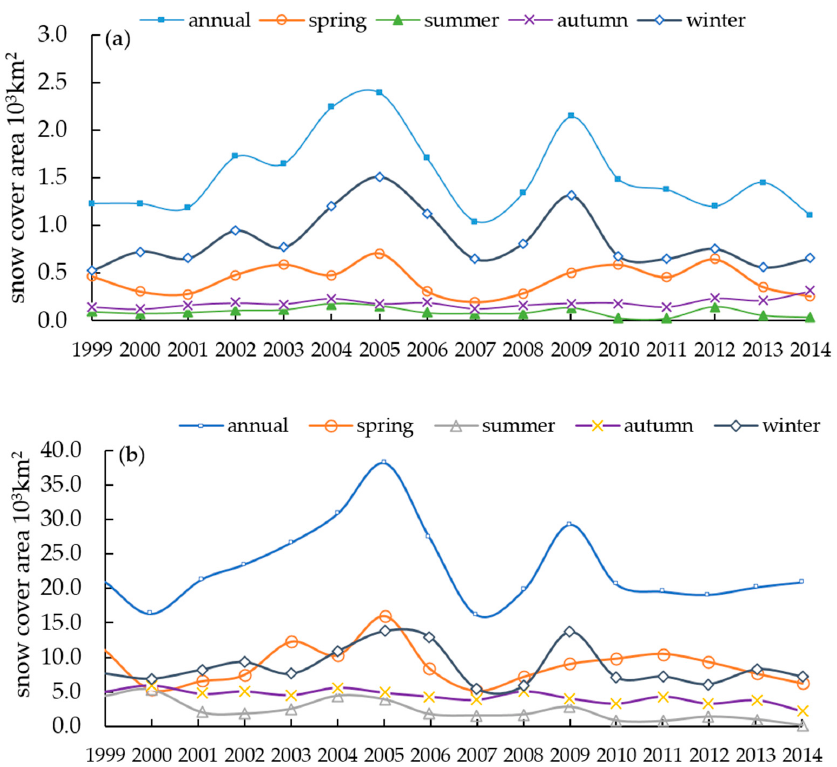
Figure 7. Annual and seasonal snow cover variation of Kashgar River ( a ) and Yarkant River ( b ).